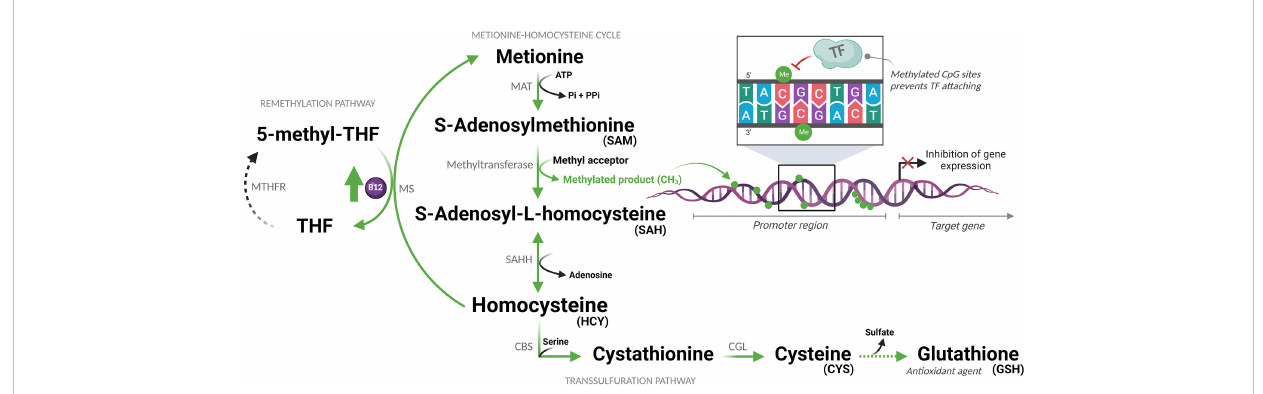
FIGURE 1 Sulfur amino acid pathway. Methionine is converted to S-adenosylmethionine (SAM), which is the methyl donor for numerous reactions. Upon losing its methyl group, SAM becomes S-adenosyl-L-homocysteine (SAH), which is then converted to homocysteine (HCY). This is then converted back to methionine or enters the transsulfuration pathway to form other sulfur-containing amino acids. MAT, Methionine adenosyltransferase; ATP, Adenosine triphosphate; Pi, Phosphate (inorganic); PPi, Pyrophosphate; THF, Tetrahydrofolate; MTHFR, Methylenetetrahydrofolate reductase; MS, Methionine synthase; B12, Vitamin B12; CH 3 /Me, Methyl group; TF, Transcription factors; SAHH, Adenosylhomocysteinase; CBS, Cystathionine beta- synthase; CGL, Cystathionine gamma-lyase. (Created with